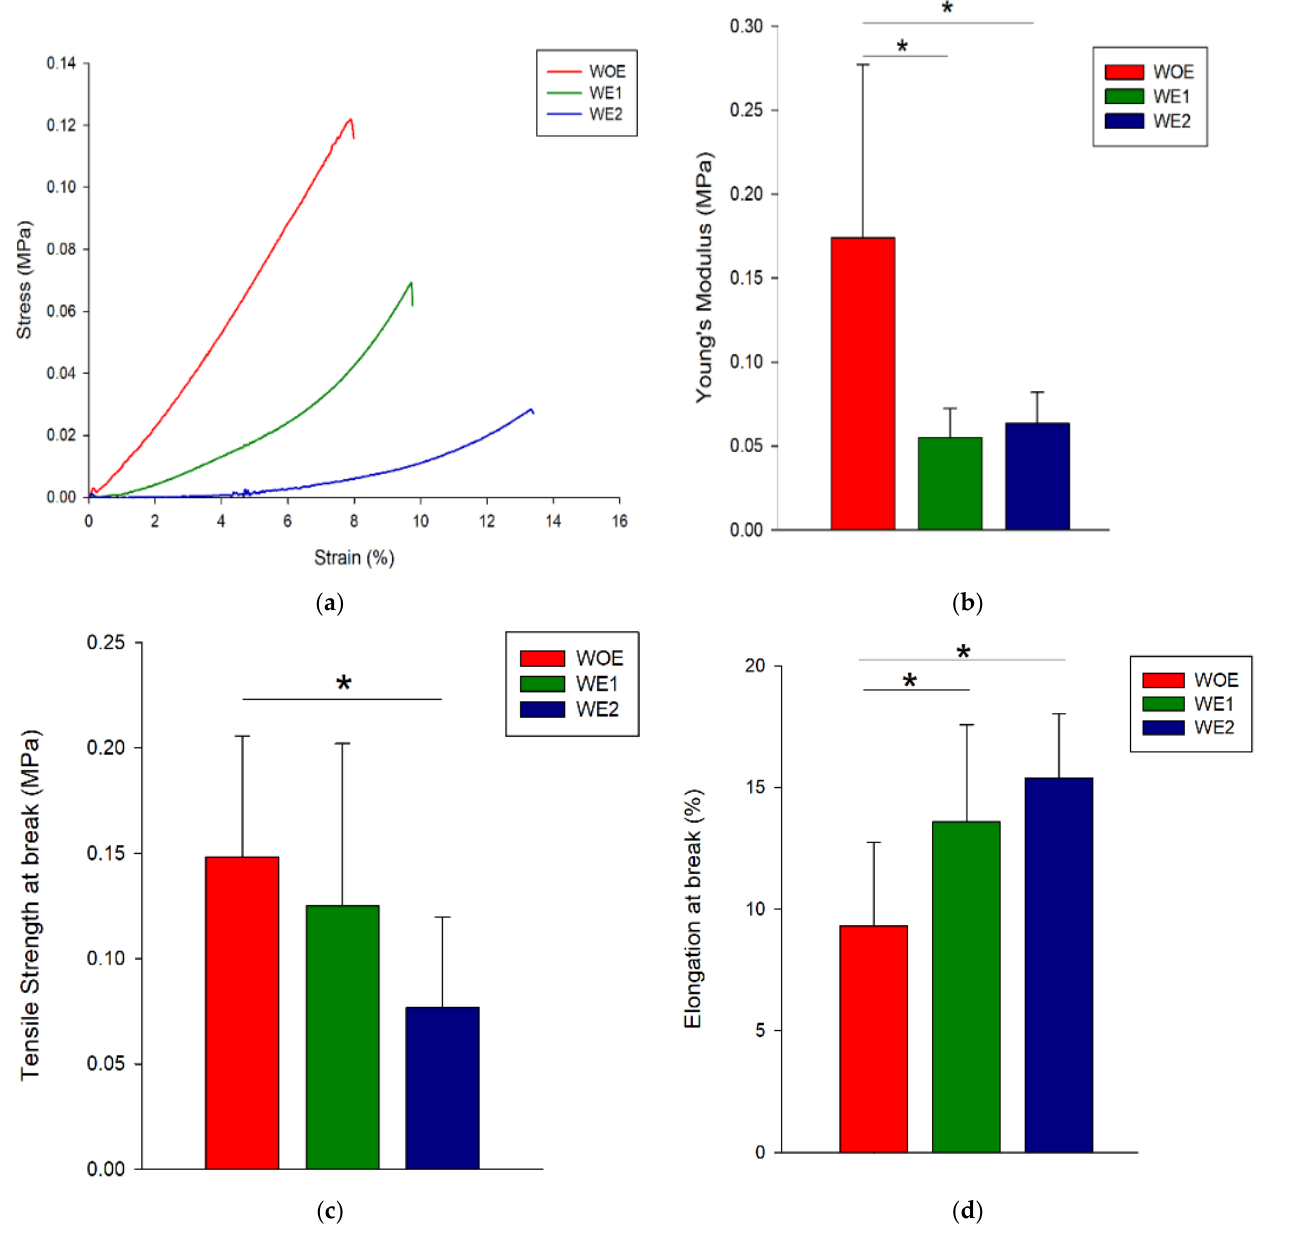
Figure 3. Mechanical behavior of WOE, WE1, and WE2 electrospun meshes in the wet state. ( a ) Stress–strain representative curves, ( b ) Young’s modulus, ( c ) tensile strength at break, ( d ) elongation at break. Statistical significance for p ≤ 0.05 (*), n = 15.